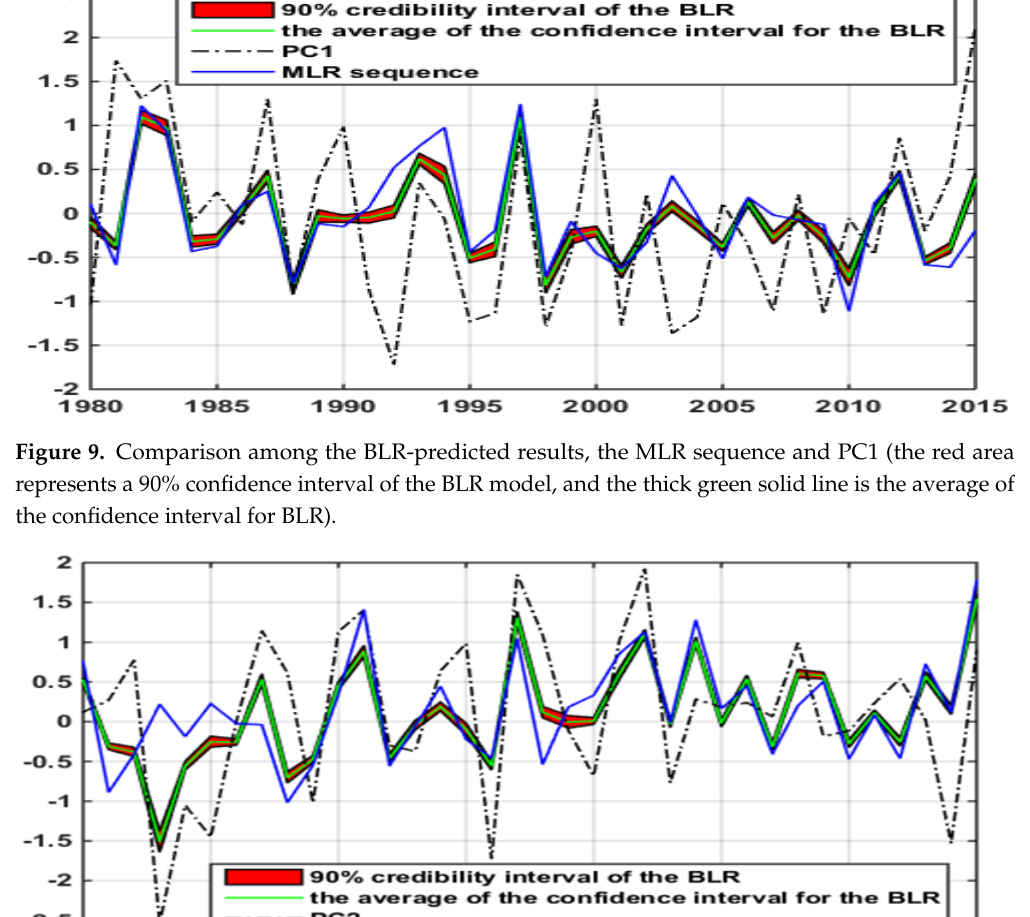
Figure 8. Figure 7Histograms of the BLR parameters of PC2 that map all uncertainty onto the parameter space ( a – g refer to each regression coefficient).